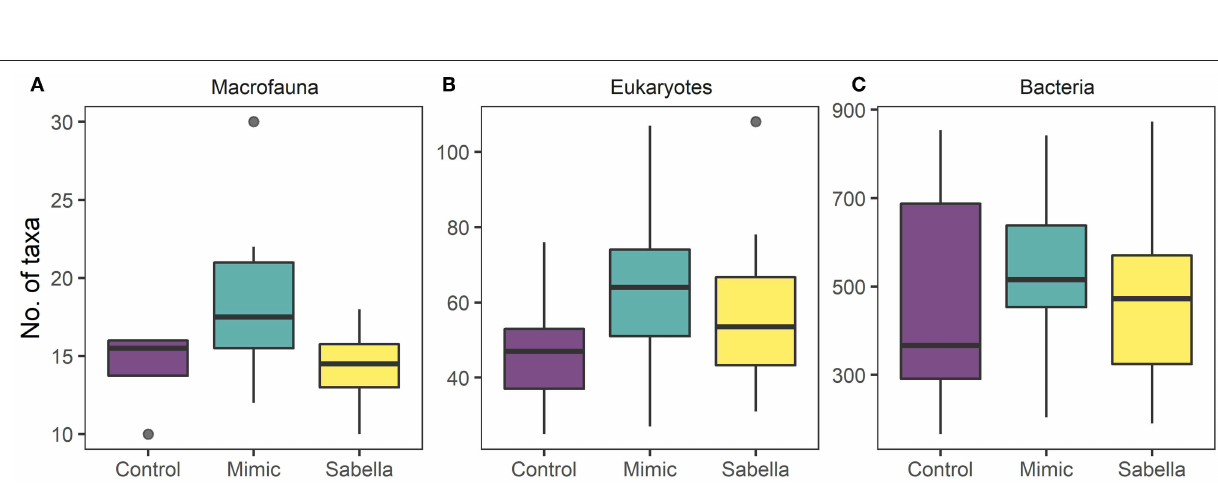
Frontiers in Ecology and Evolution |